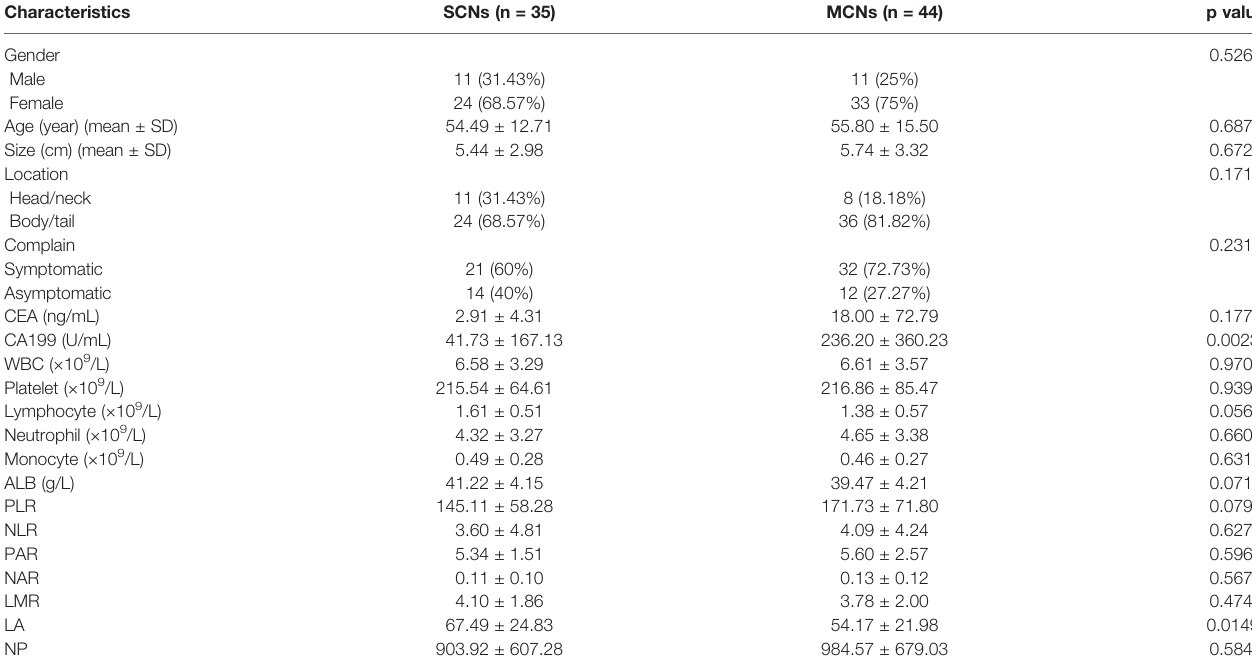
TABLE 1 | Comparison of preoperative indices between patients with SCNs and MCNs. Characteristics